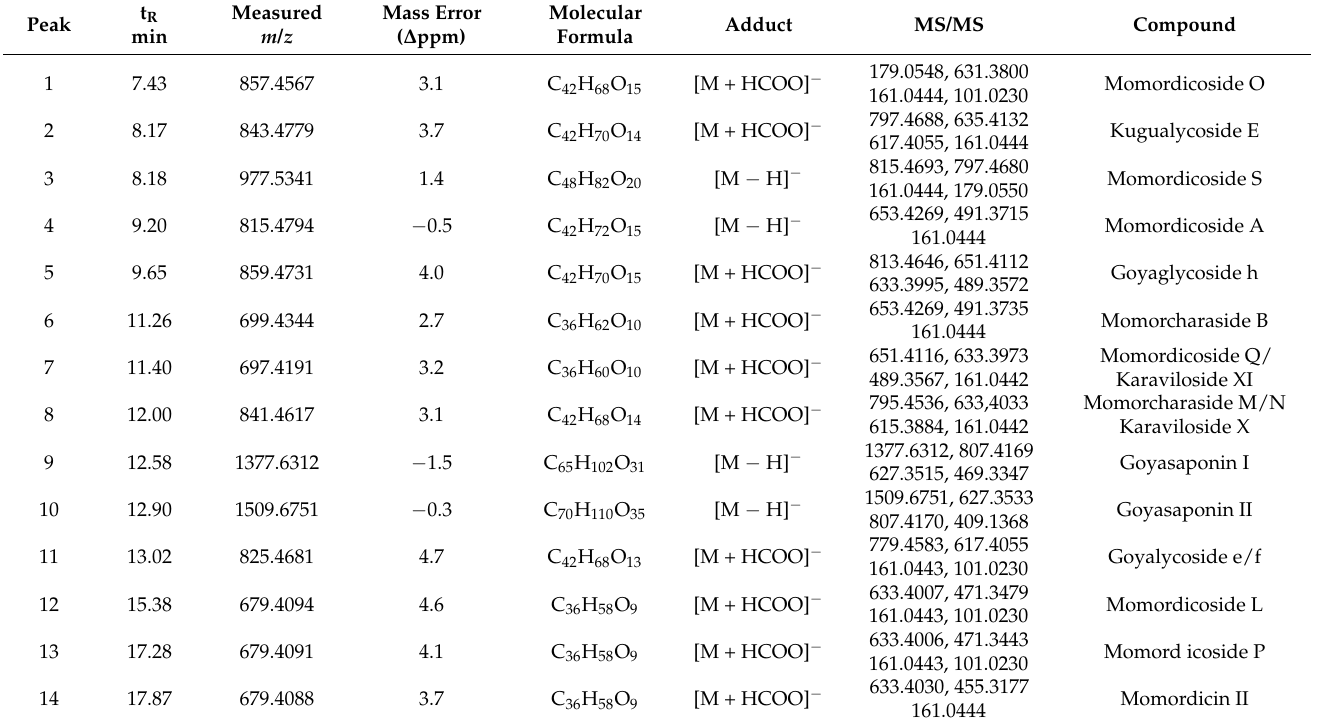
Figure 2. MS/MS spectrum ( A ) and the EIC ( B ) of goyasaponin II and MS/MS spectrum ( C ) and the EIC ( D ) of momordicoside A. Table 1. Compounds identified in MCE using UHPLC-MS and MS/MS.